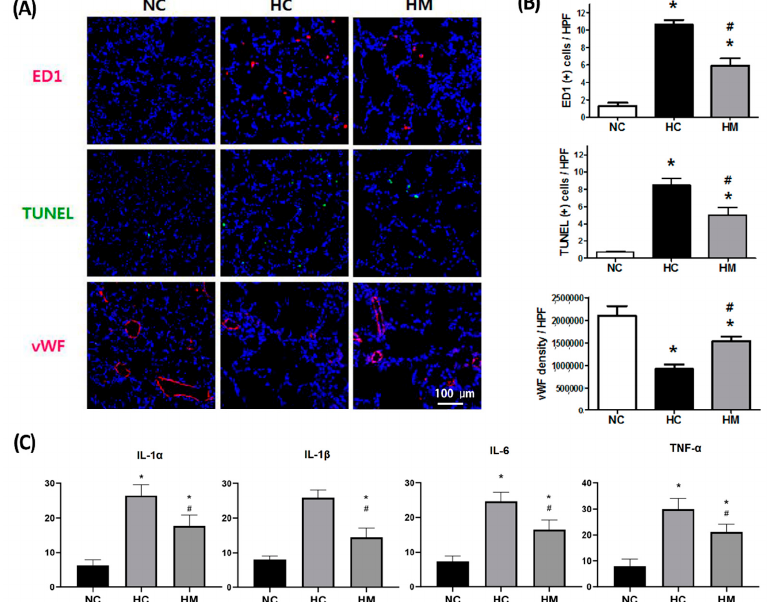
Figure 2. Evidence of inflammation, cell death, and pulmonary angiogenesis in P14 rat pups. ( A ) Representative immunofluorescence photomicrographs of ED ‐ 1 ‐ positive cells, TUNEL ‐ positive cells, and von Willebrand factor (vWF) staining in the lungs of P14 rats. ED ‐ 1 ‐ positive alveolar mac ‐ rophages and vWF were labeled with the fluorescent marker (red), and TUNEL was labeled with FITC (green). Nuclei were labeled with 4 ′ ,6 ‐ diamidino ‐ 2 ‐ phenylindole (DAPI, blue) (scale bars = 100 μ m). ( B ) Numbers of observed TUNEL ‐ and ED ‐ 1 ‐ positive cells and mean light signal intensity of vWF immunofluorescence staining per high power field in lung sections from P14 rats. ( C ) Levels of inflammatory cytokines of IL ‐ 1 α , IL ‐ 1 β , IL ‐ 6, and TNF ‐α in the lungs of P14 rats. Data are pre ‐ sented as the mean ± standard deviation. Abbreviations: NC, normoxia control; HC, hyperoxia con ‐ trol; HM, hyperoxia with transplantation of human UCB ‐ MSCs. *, p < 0.05 compared with the NC group; #, p < 0.05 compared with the HC group.